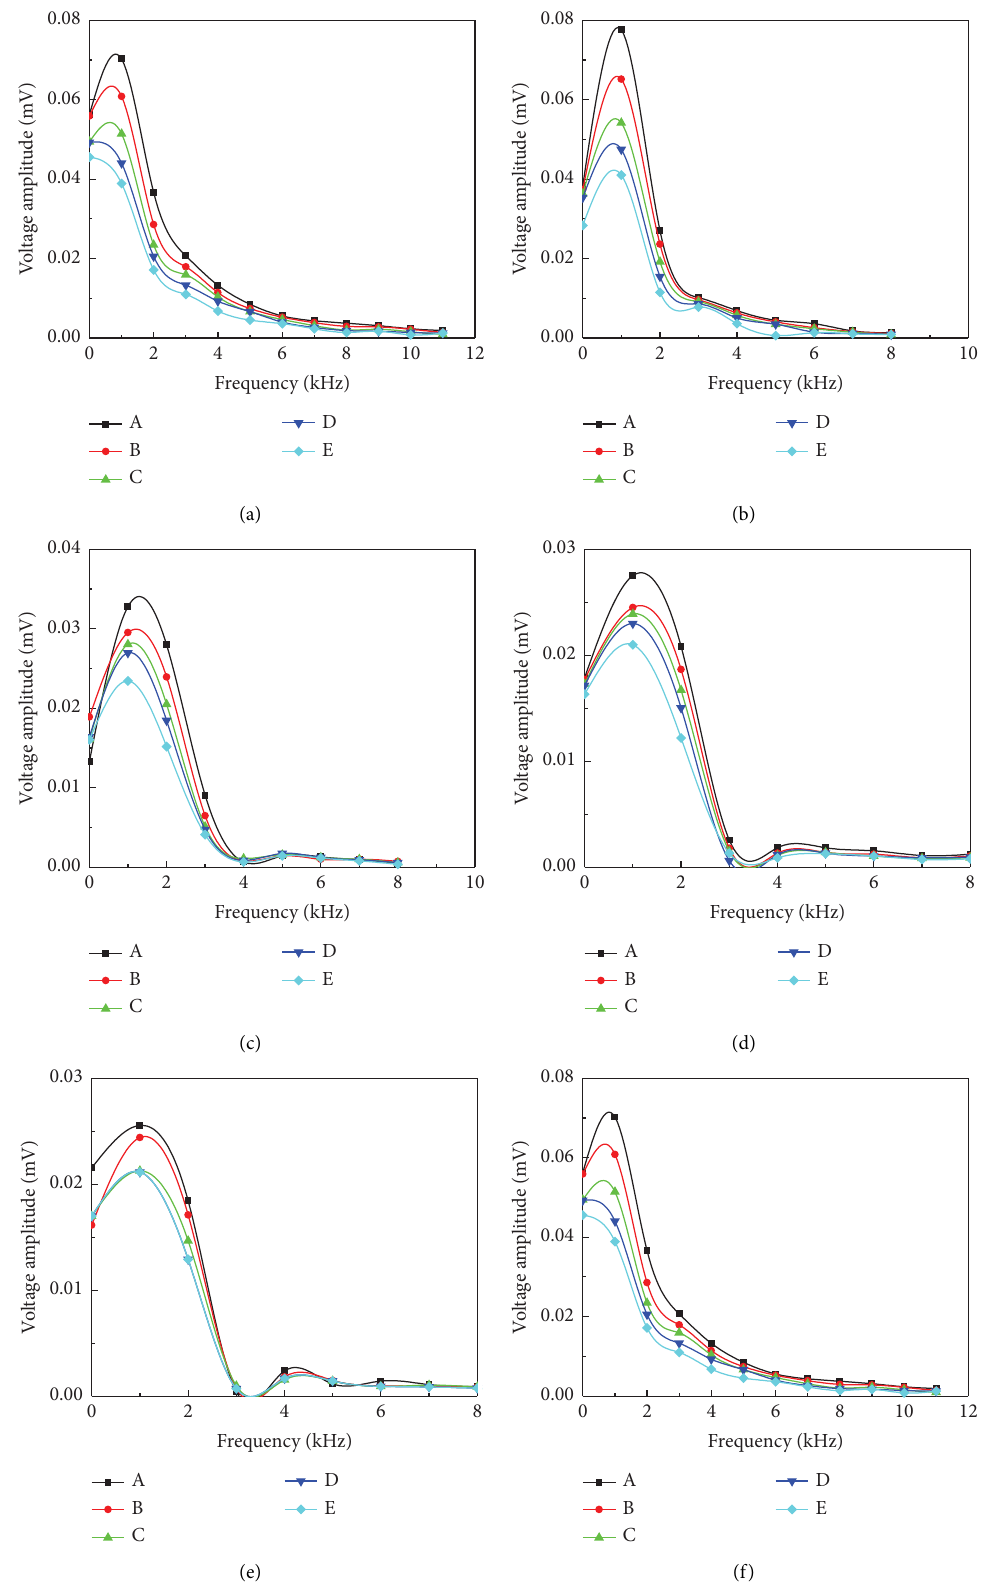
Figure 5: Frequency spectrum curves of stress wave. (a) 0MPa. (b) 2.76MPa. (c) 11.04MPa. (d) 19.32MPa. (e) 27.60MPa. (f)